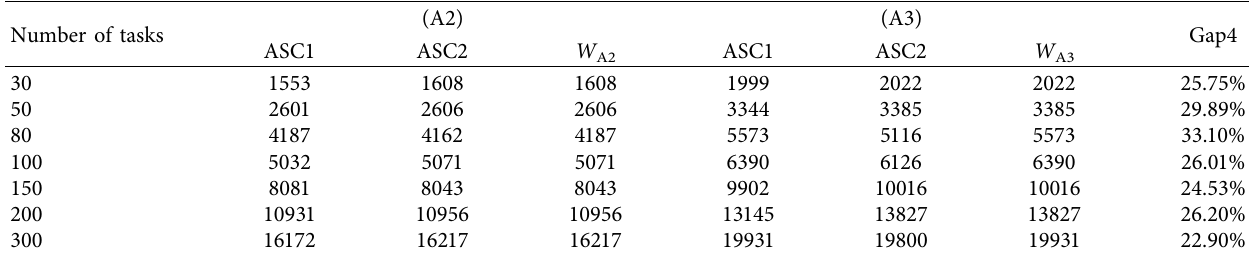
Table 6: Comparisons among (A2) and